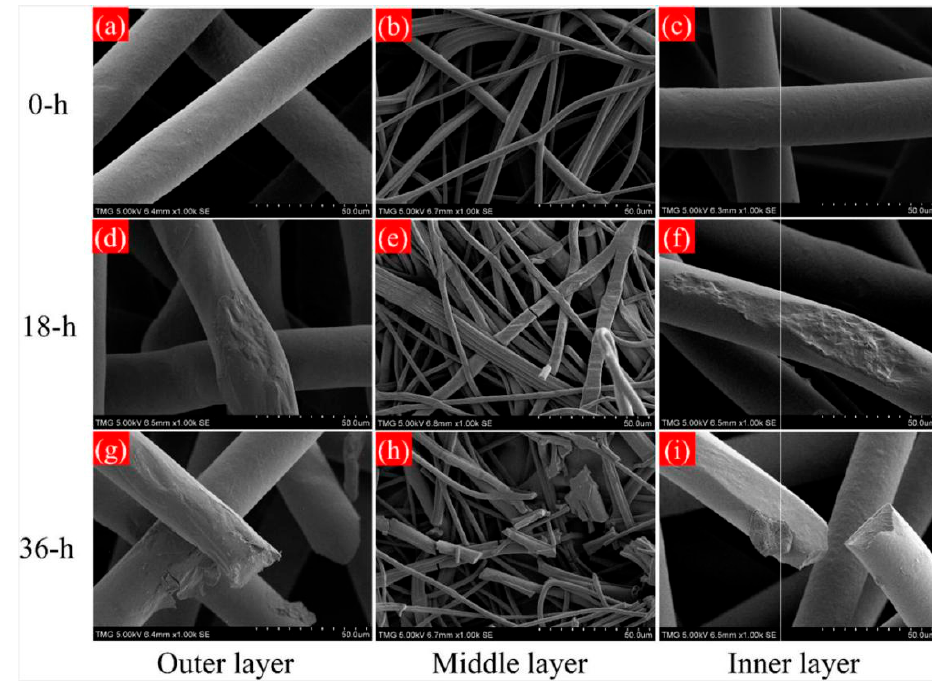
Figure 2. SEM images for the three layers of masks with different UV weathering durations: ( a , d , g ) Images at 1000 magnification of the outer layer of mask with UV irradiation for 0, 18 and 36 h ( b , e , h ). Images at 1000 magnification of the middle layer of mask with UV irradiation for 0, 18 and 36 h ( c , f , i ). Images at 1000 magnification of the inner layer of mask with UV irradiation for 0, 18 and 36 h [47].